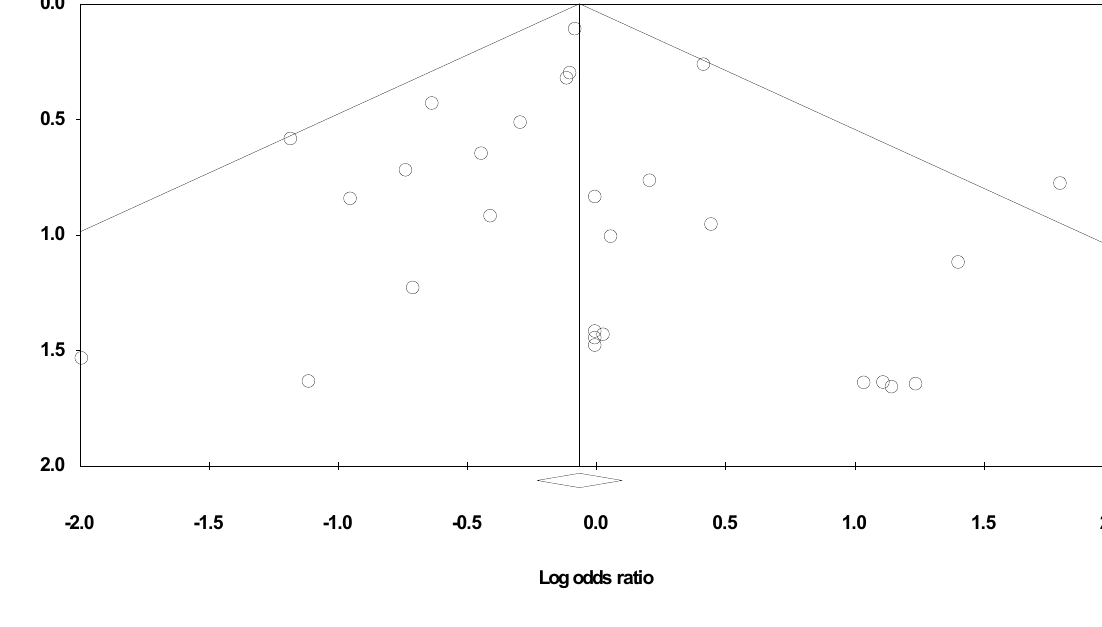
Supplementary Fig. 4 – Funnel plot showing the incidence of myocardial infarction. Begg and Mazumdar’s test (P value): 0.167 and Egger’s test (P value):